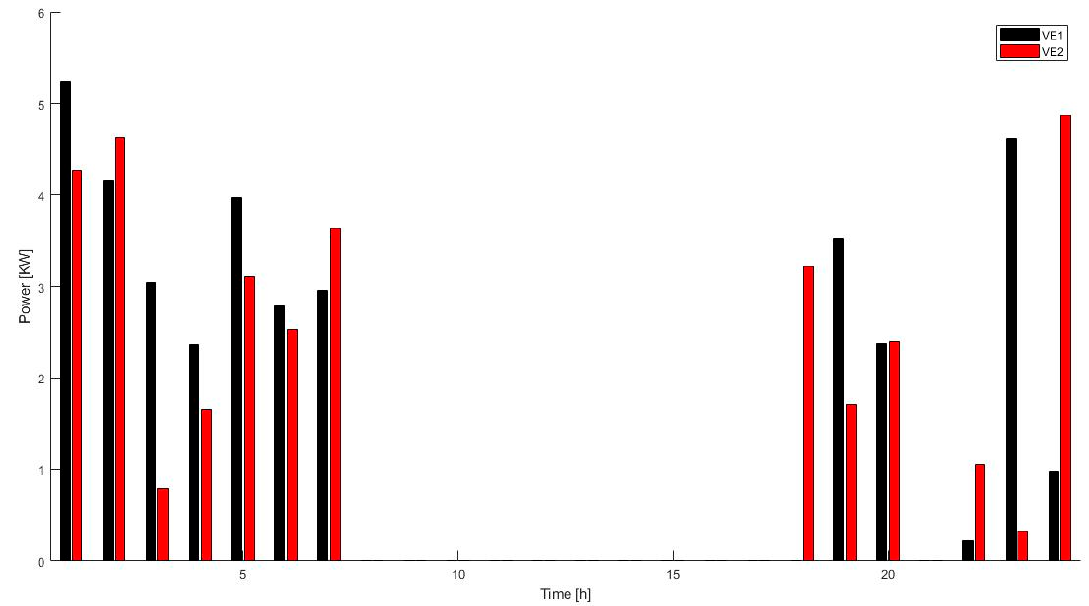
Figure 4. Load of the two electric vehicles of the two aggregators under study.